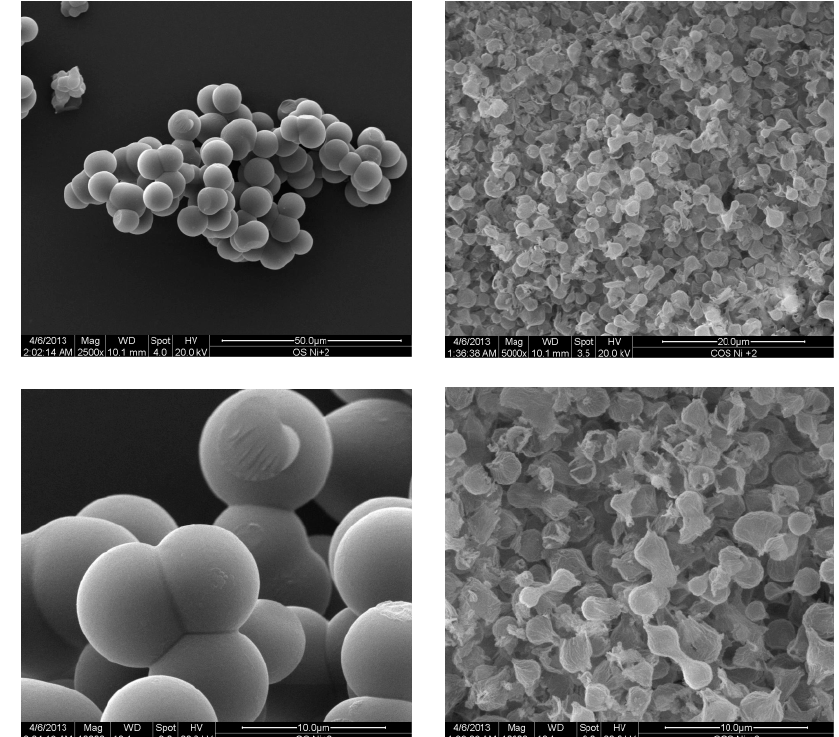
Figure 3. Materials produced by HTC of Ni(NH 4 ) 2 (SO 4 ) 2 ·6H 2 O–Mimosa tannin solution at different magnifications: before ( left ) and after ( right ) calcination in air; SEM pictures.